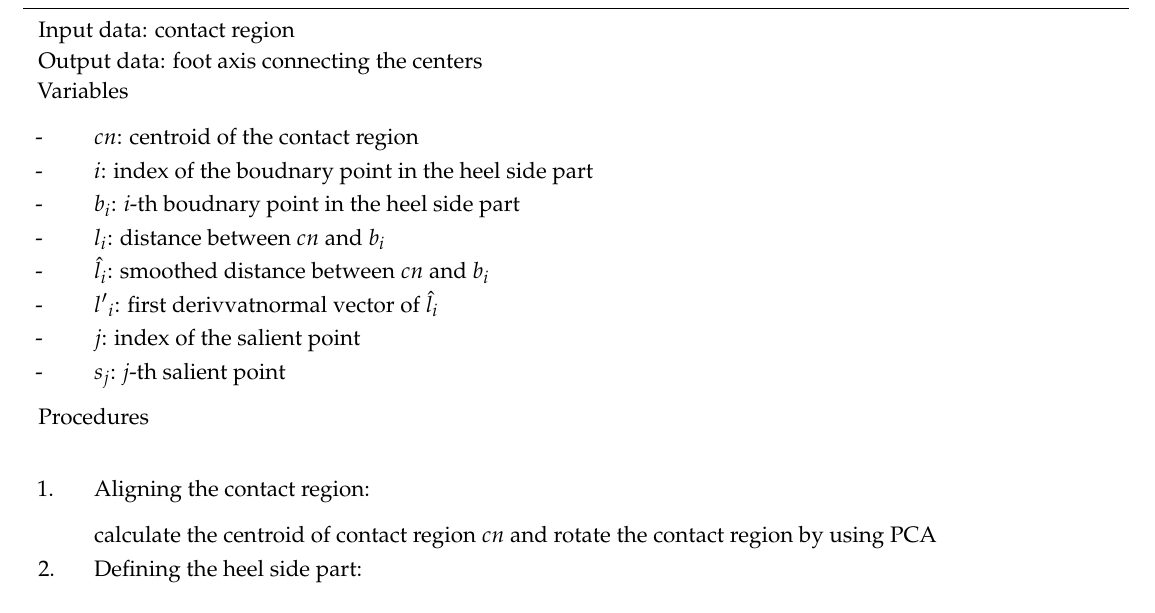
Algorithm 2 Procedures of Foot Axis